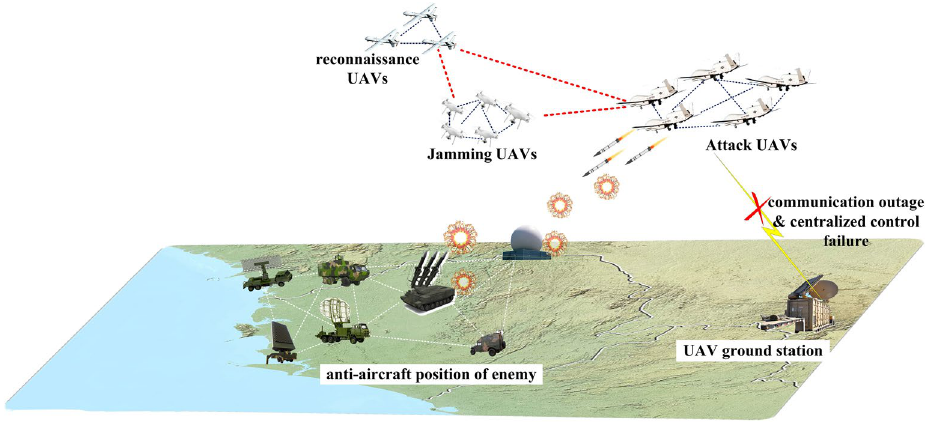
Figure 1. Autonomous collaboration of unmanned